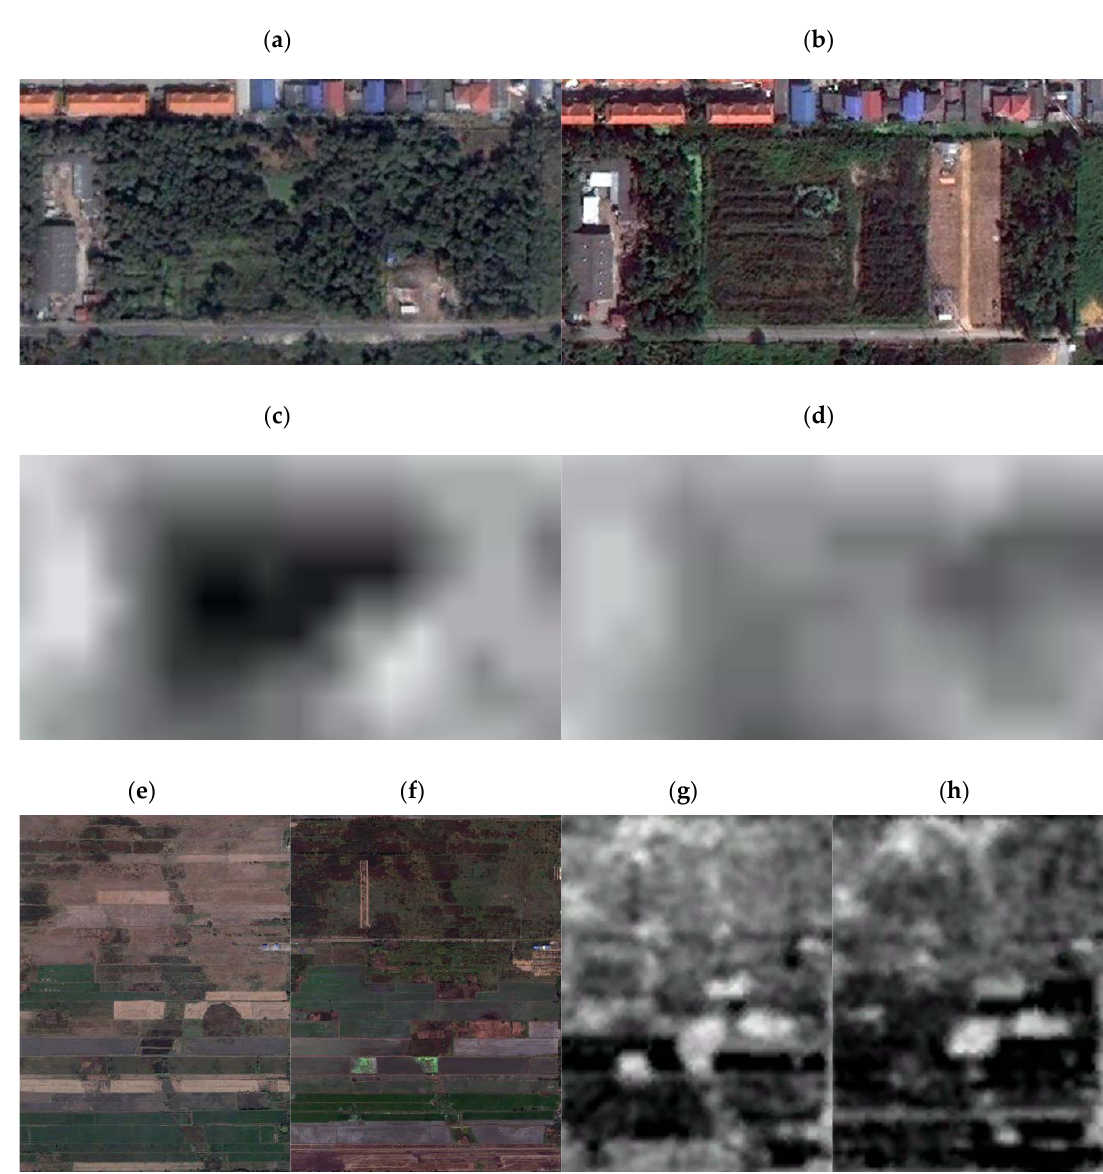
Figure 19. Examples of changes ignored by the model: ( a ) optical image of forest area from 18 December 2004, ( b ) optical image of forest area from 15 April 2010, ( c ) SAR image of forest area from 27 November 2008, ( d ) SAR image of forest area from 15 January 2010, ( e ) optical image of paddy field area from 18 December 2004, ( f ) optical image of paddy field area from 15 April 2010, ( g ) SAR image of paddy field area from 27 November 2008, ( h ) SAR image of paddy field area from 15 January 2010 (the resolution of each image is 0.14 km × 0.265 km for ( a–d ) and 1.5 km × 1.2 km for ( e–h )).